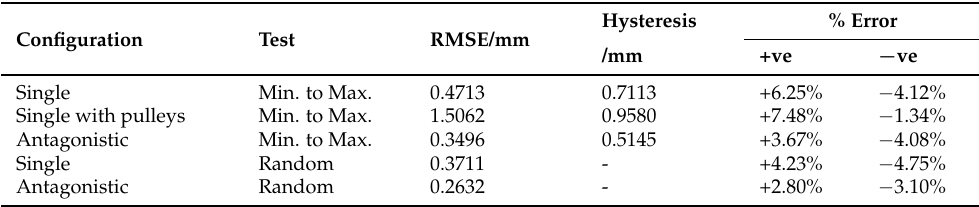
Table 2. Summary results table for each of the one-DOF tests.